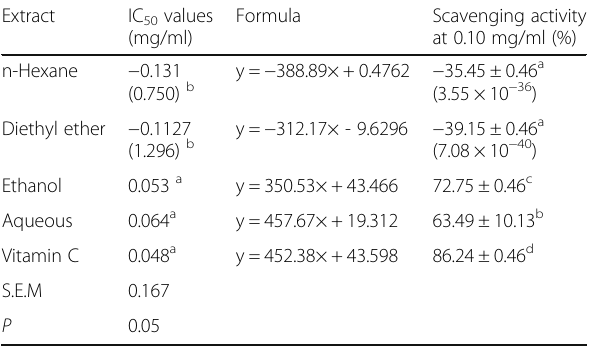
Table 3 DPPH Inhibitory Concentration (IC 50 ) of the extracts